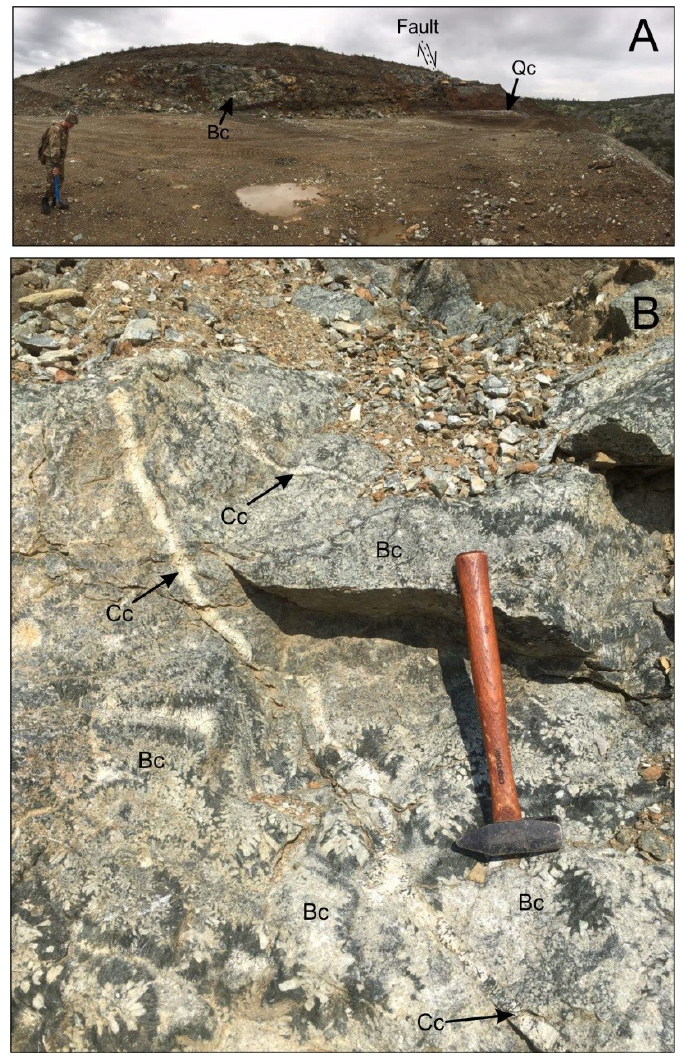
Figure 3. The “carbonated” open pit: ( A ) a general view with shown sites of benstonite carbonatite (Bc) and quartz carbonatite (Qc) blocks separated by a fault; ( B ) a close view of benstonite carbonatite (Bc) cut by calcite carbonatite (Cc) veins.